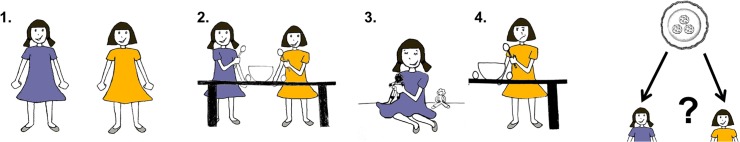
Example of a set of vignettes used in the experiment (other vignette sets were available so that the identity of the big contributor could be counterbalanced across participants.Pictures 1, 2 and 5 remained constant).